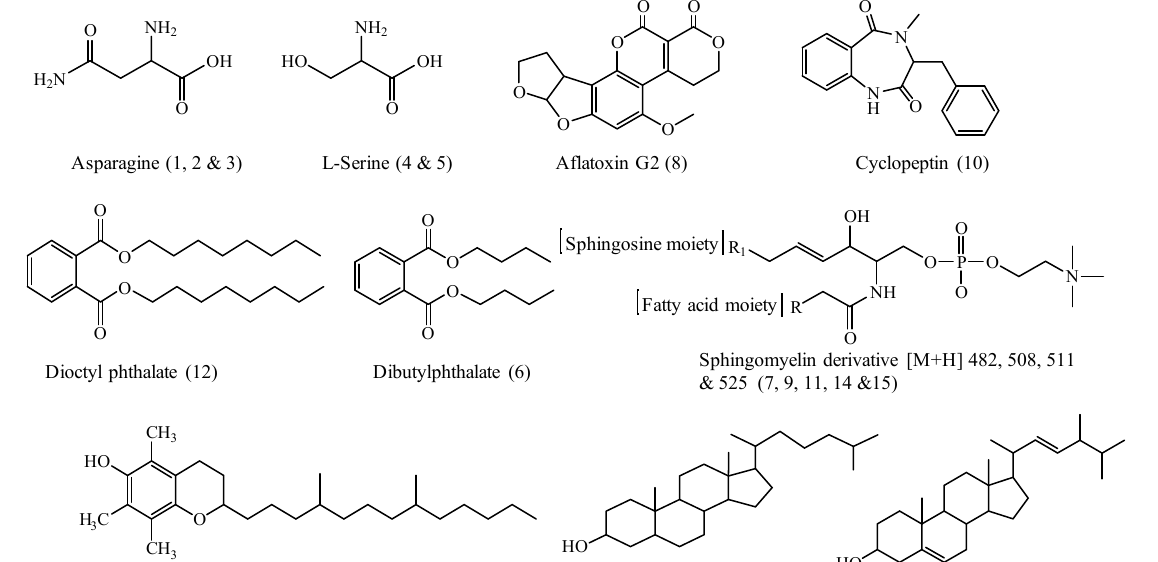
Figure 2. UPLC-ESI-MS chromatogram of Cliona sp. n- hexane, fraction in positive (+) ionization mode, numbers 1–21 refer to the tentatively identified compounds in n -hexane, fraction.